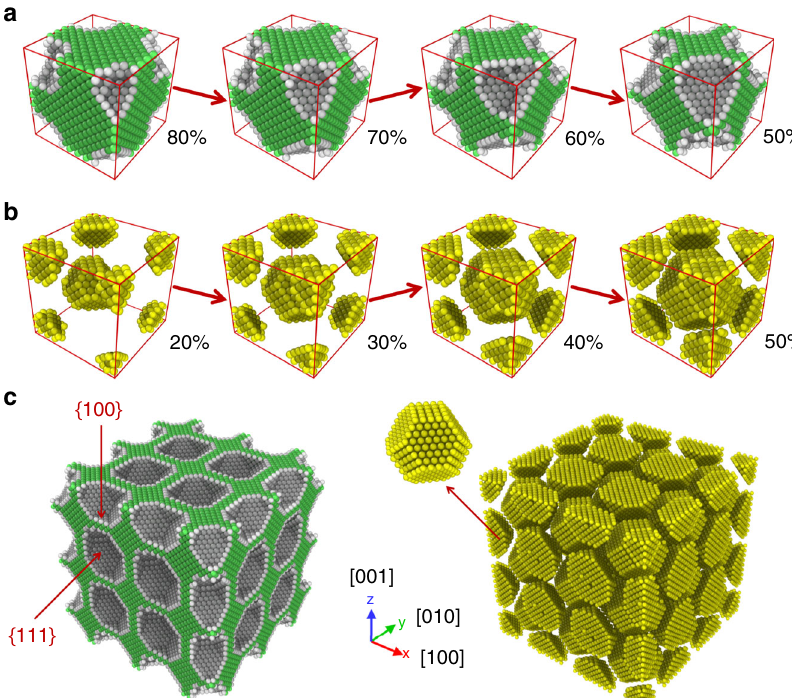
Fig. 2 Nano-TO designs for maximizing bulk modulus. a The Nano-TO designs for maximizing the bulk modulus with varying volume fractions from 50 to 80%. The bulk atoms are shown in green and the surface atoms are shown in gray. b The corresponding distributions of virtual atoms. c Periodic images (3 × 3 × 3) of the Nano-TO design with a volume fraction of 50% and the corresponding distribution of virtual atoms. The surfaces in the Nano-TO designs are mostly {111} and {100}. The virtual atoms form truncated octahedron structures in the BCC